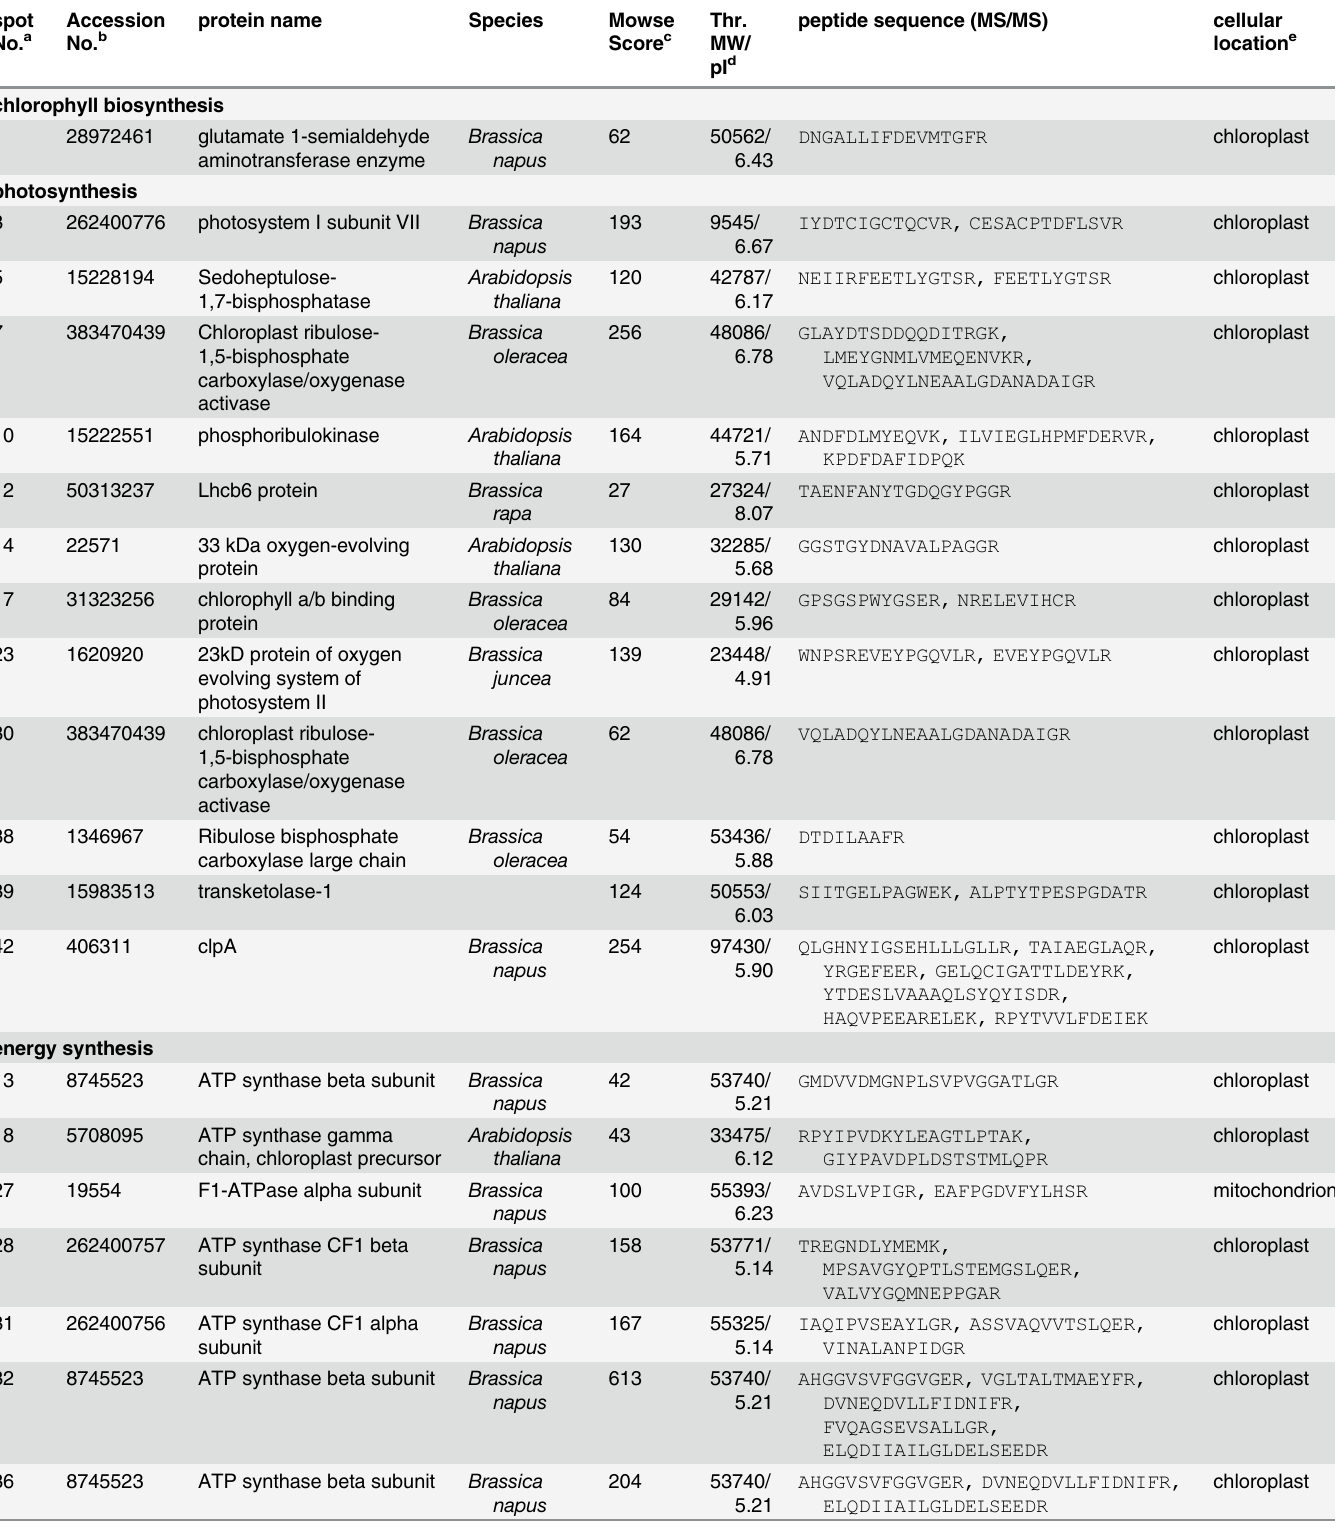
Table 2. Identification of differentially accumulated proteins under salt stress in leaves of Brassica napus . spot No.